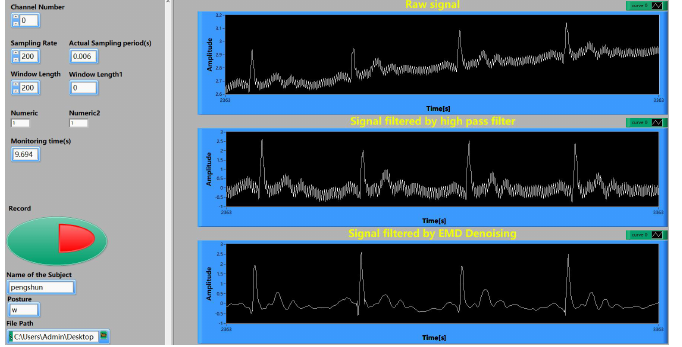
Figure 4. User interface of host computer